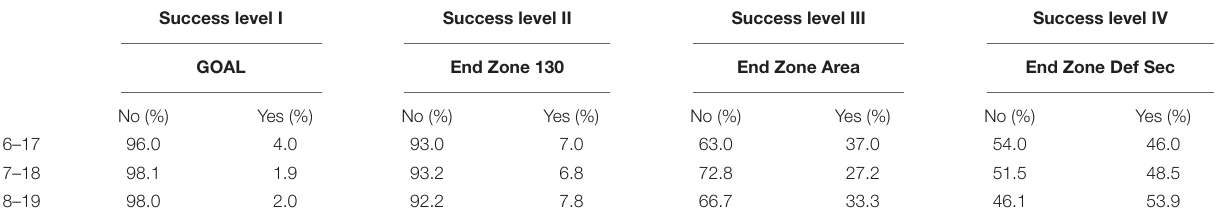
TABLE 7 | Contingency table: Season * Level of Success.